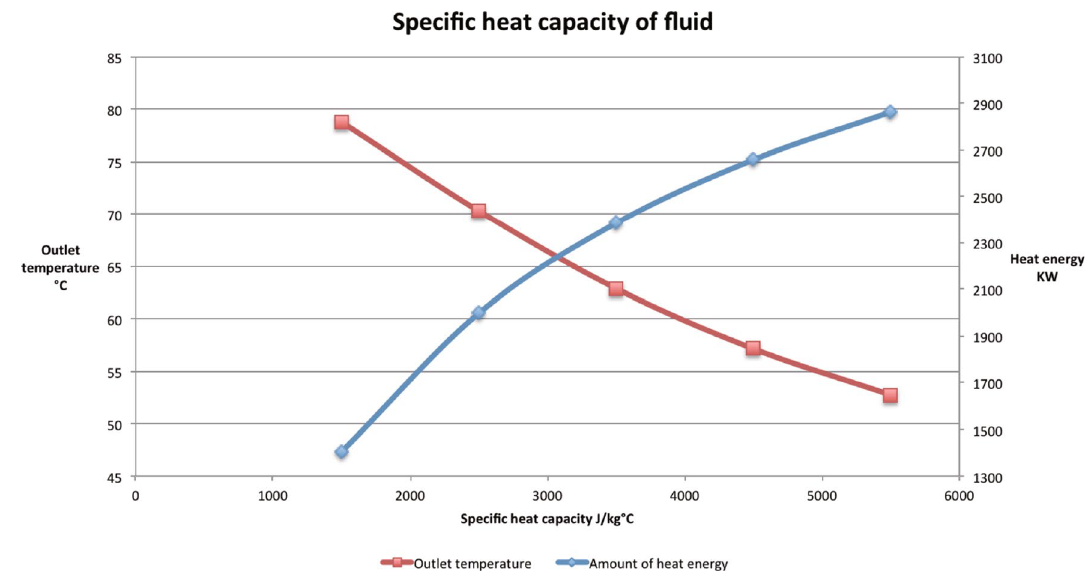
Fig. 4 Temperature and heat energy regarding working fluids’ heat